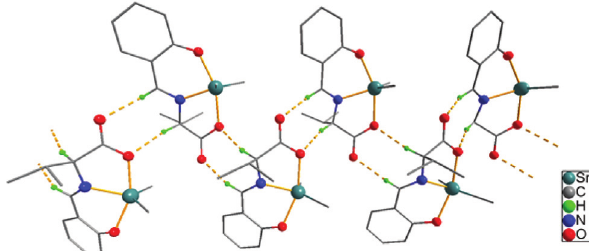
Figure 4: The 1D supramolecular chain in 2 and 5 formed by the intermolecular C–H (cid:1101)(cid:1101)(cid:1101) O hydrogen bonds. Some C, H and O atoms are not shown for clarity.